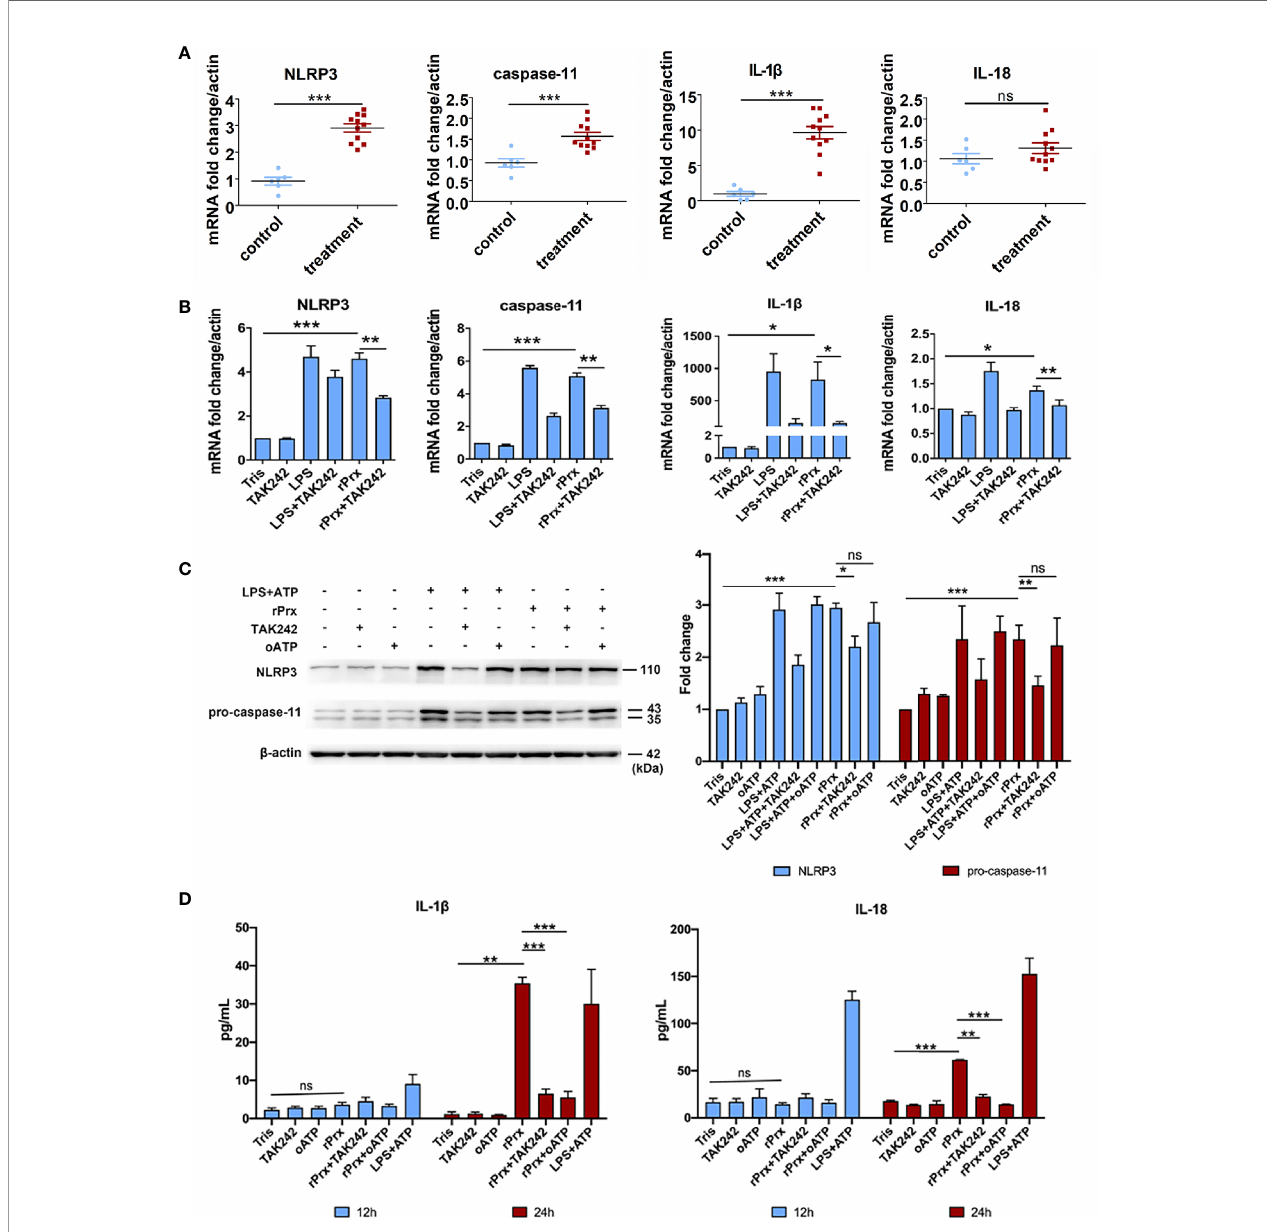
FIGURE 3 | Eh -rPrx-Activation of NLRP3 In fl ammasome in RAW264.7 Cells. (A) Female C57BL/6 mice were treated by intraperitoneal injection of Eh -rPrx (100 m g/ mouse); Tris-HCl (pH 8.0) was used as the negative control. Twelve hours after the treatment, PEC (containing macrophages) were collected, and the expression levels of related genes were measured by qPCR and shown as 2- DD Ct of the target gene relative to b -actin, normalized with corresponding values in the negative control. In control group, n = 6; in treatment group, n = 11. Experiments were repeated twice. (B) Gene expression levels detected by qPCR. RAW264.7 cells were treated with 5 m g/mL of Eh -rPrx, while LPS (1 m g/ml) and Tris-HCl (pH 8.0) was used as the control. Six hours after the treatment, the expression levels of related genes were measured by qPCR, and shown as 2- DD Ct of the target gene relative to b -actin, normalized with corresponding values. In all groups, n = 3. Experiments were repeated three times. (C) Western blot analysis of NLRP3 in fl ammasome-related proteins. RAW264.7 cells were pretreated with TAK242 (1 m M) for 1 h or oATP (500 m M) for 2 h. Next, the cells were treated with either 5 m g/mL of Eh -rPrx, 1 m g/mL of LPS, or Tris-HCl (pH 8.0). For the positive control, ATP (4 mM) was added at the last 2 h of incubation. Six hours after the treatment, the cells were collected, and the cell lysis was analyzed by western blotting. In all groups, n = 3. Experiments were repeated three times. (D) Release of IL-1 b and IL-18 in the supernatant of Eh -rPrx-treated cells. RAW264.7 cells were pretreated with TAK242 (1 m M) for 1 h or oATP (500 m M) for 2 h. Next, cells were treated with either 5 m g/mL of Eh -rPrx, 1 m g/mL of LPS, or Tris-HCl (pH 8.0). For the positive control, ATP (4 mM) was added at the last 2 h of incubation. Cell culture supernatant was collected after 12 and 24 h of treatment, and analyzed by enzyme-linked immunosorbent assay. In all groups, n=3. Experiments were repeated three times. Statistical analysis was conducted by Student ’ s t -test, and data are presented as mean ± SEM. *p < 0.05, **p < 0.01, ***p < 0.001, ns, not signi fi